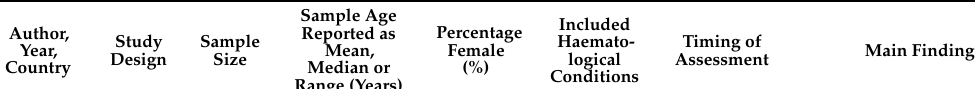
Table 1. Included quantitative